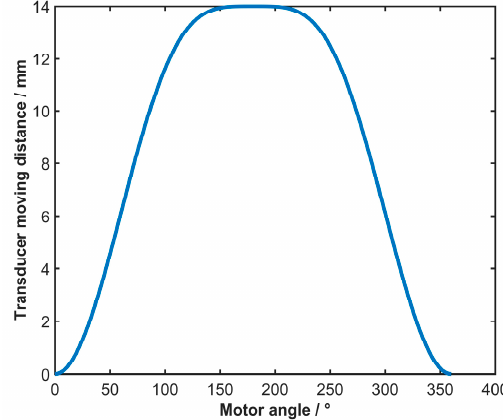
Figure 7. The movement trace of the mechanical scanning.